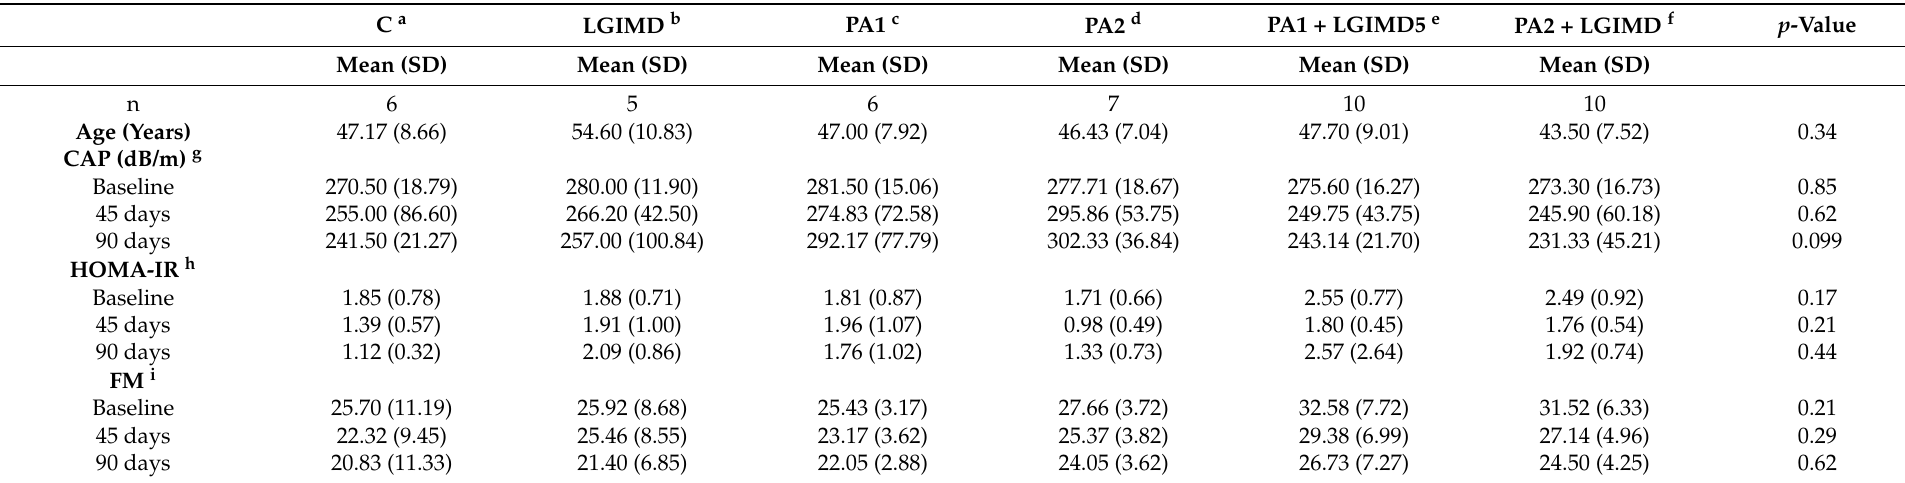
Table A2. Anthropometric and Biochemical Characteristics of Moderate NAFLD Participants by Intervention Arms and Time. NutriAtt Trial, Castellana Grotte,